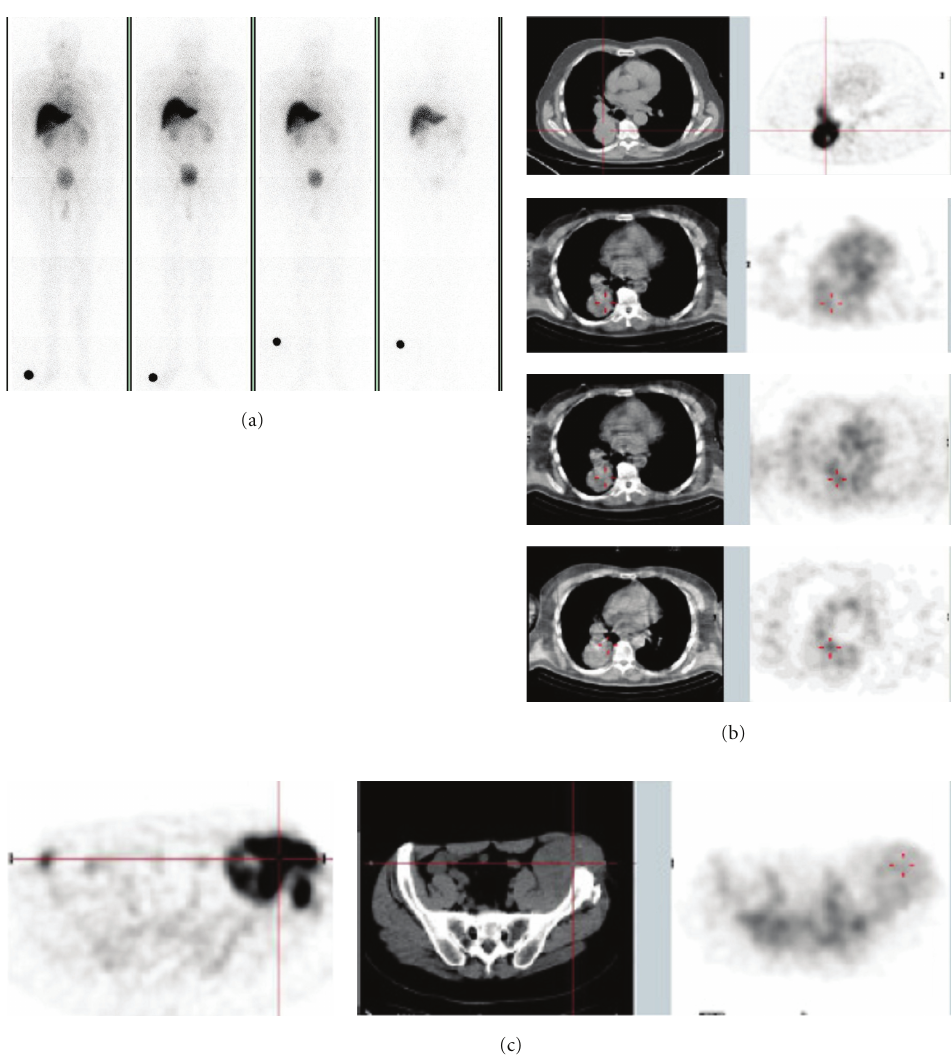
F 1: Imaging of patients with Re-6D2 mAb. (a) Whole-body scintigraphic image of a patient from Phase Ia showing absence 188